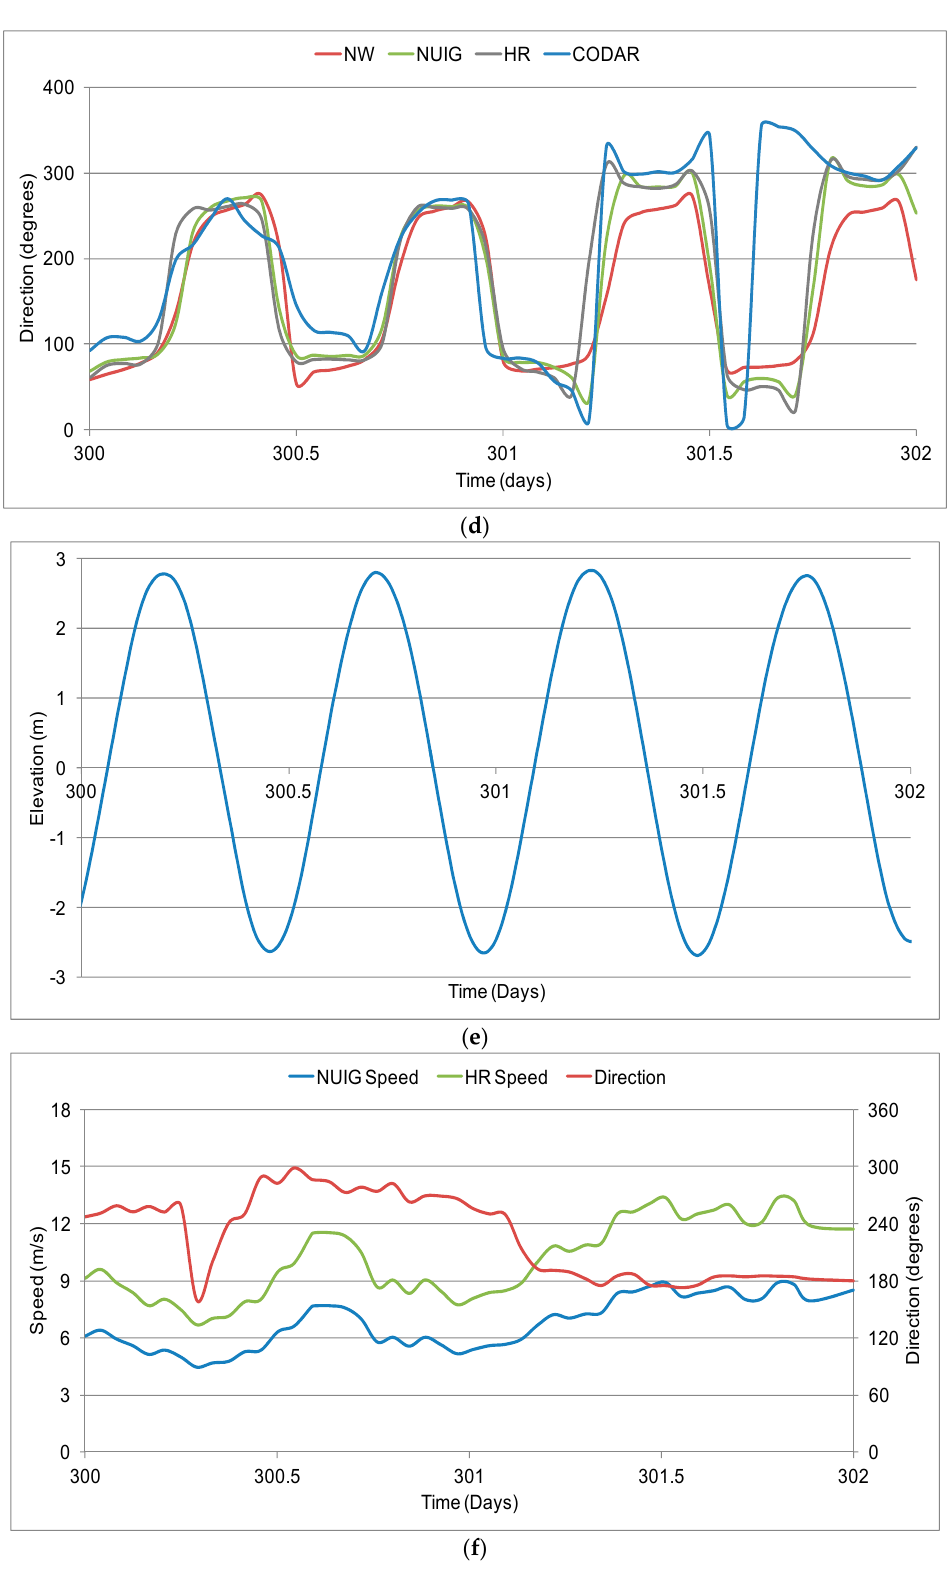
Figure 13. Comparison of modeled and measured surface currents at locations C2 during P3 (( a ), ( b ) east-west (u) and north-south (v) surface velocity components from models and measurements, respectively; ( c ) wind speed; ( d ) wind direction; ( e ) local water elevation; ( f ) wind speed and wind direction at C2).